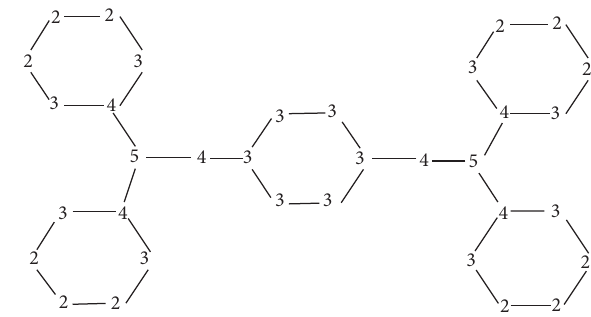
Figure 1: D [ 1 ] along with the connection of each 1